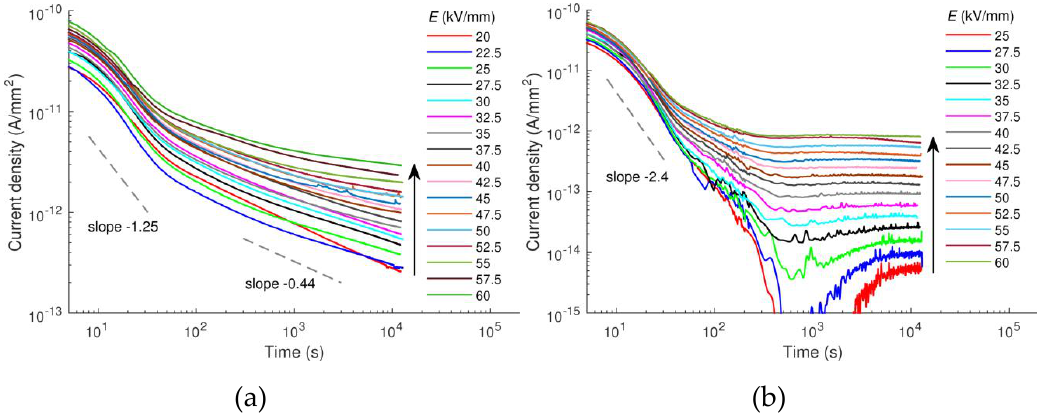
Figure 1. Time dependencies of charging current densities measured at various electric fields (in kV/mm) indicated in the legend; (a) low-density polyethylene (LDPE), 60 °C and (b) LDPE/Al 2 O 3 3 wt% nanocomposite, 80 °C. Arrows show the variation with the increasing field strength.